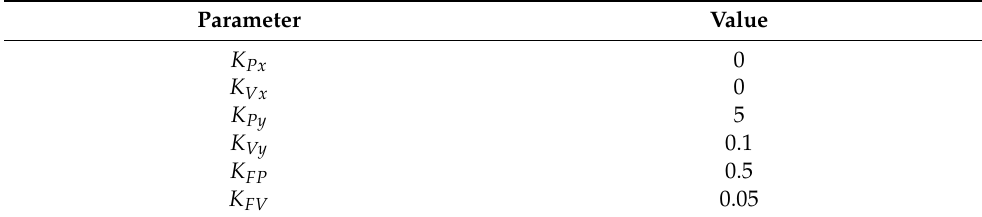
Table 2. Table 2. Parameters of the set trajectory.